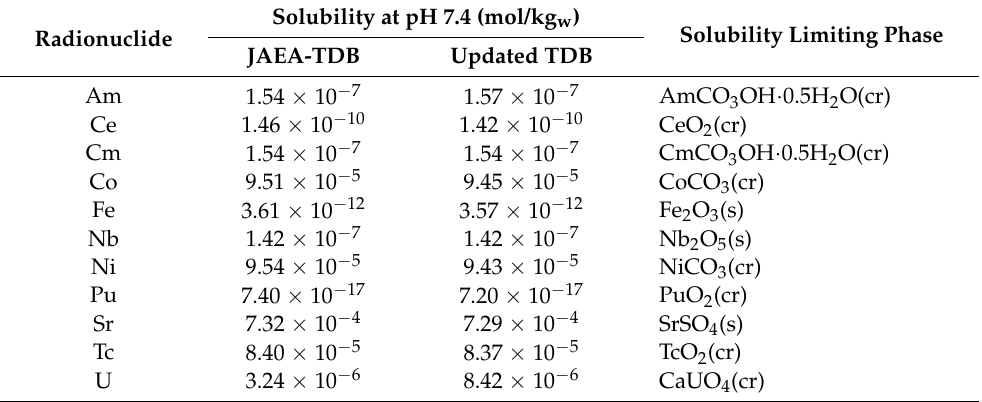
Table 3. Solubility data of various radionuclides in a natural groundwater system estimated using JAEA-TDB and updated